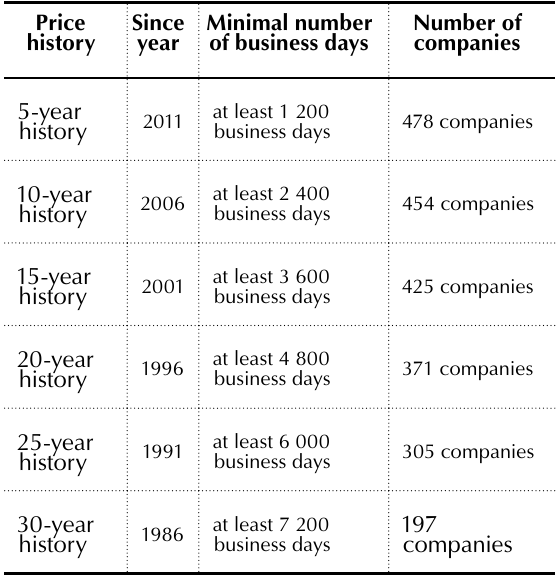
Table 1. Criterion for classification of